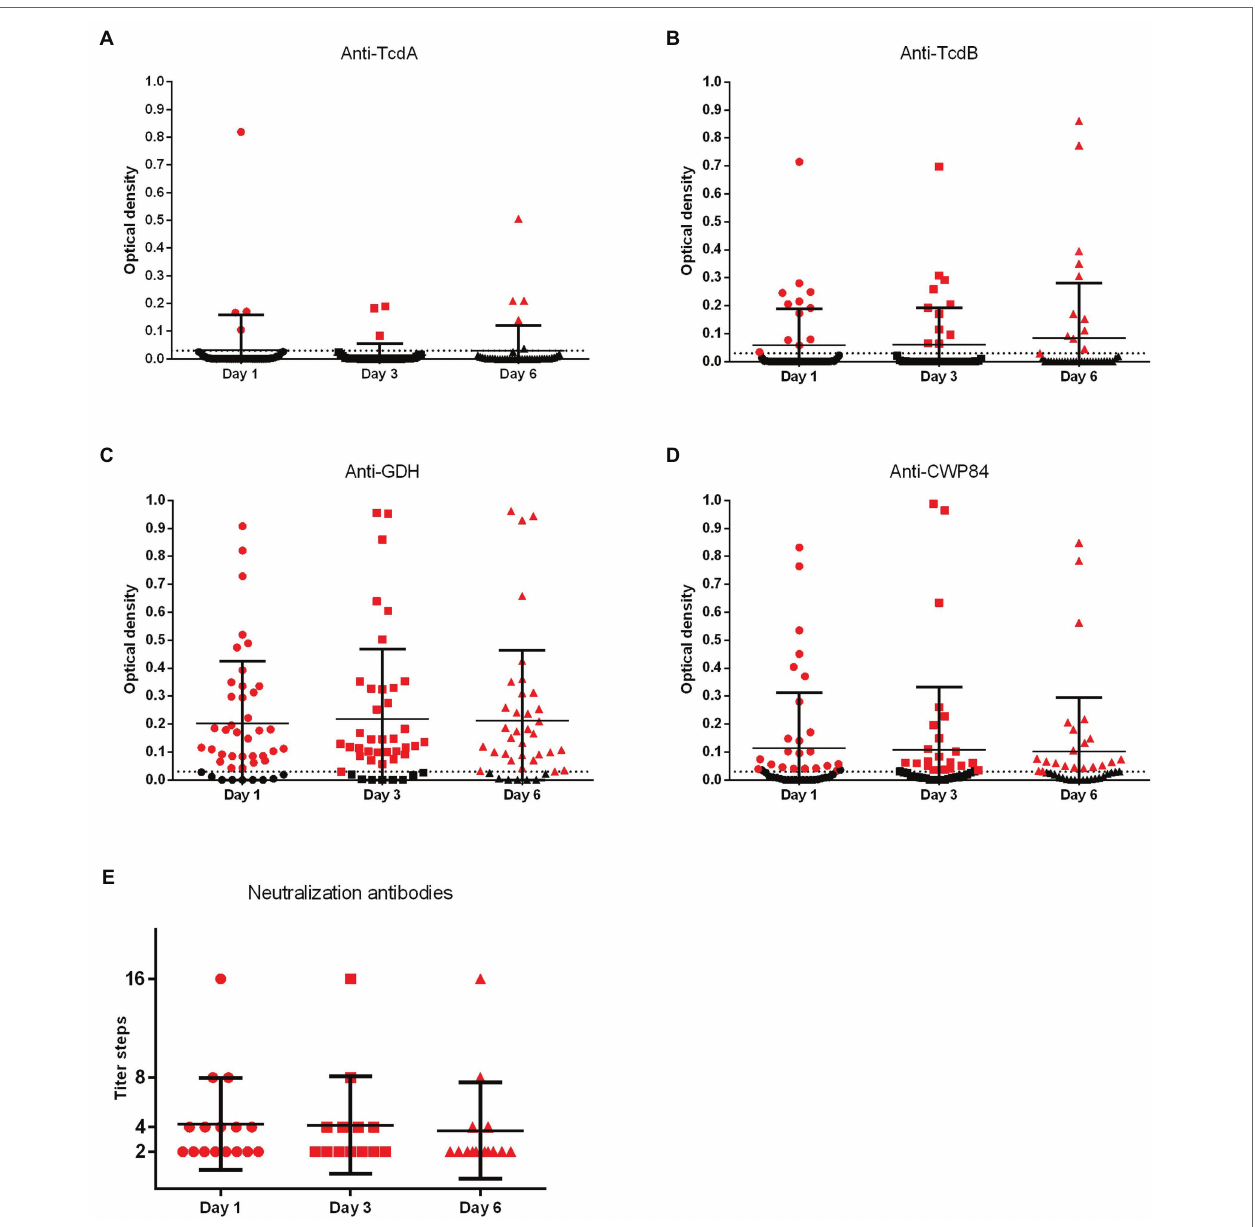
FIGURE 4 | Quantitative values of C. difficile -specific antibodies. Consecutive plasma samples were investigated 1, 3, and 6 days after diagnosis of CDI. Anti-TcdA, anti-TcdB, anti-CWP84, and anti-GDH were investigated by ELISA (TcdA, Toxin A; TcdB, Toxin B; GDH, glutamate dehydrogenase; CWP84, cell-wall protein 84). OD values of ≥ 0.03 were considered positive for ELISA (dotted line). Neutralizing antibodies to RT014 and/or RT027 were investigated with Vero B cells and neutralization titers were determined by serial